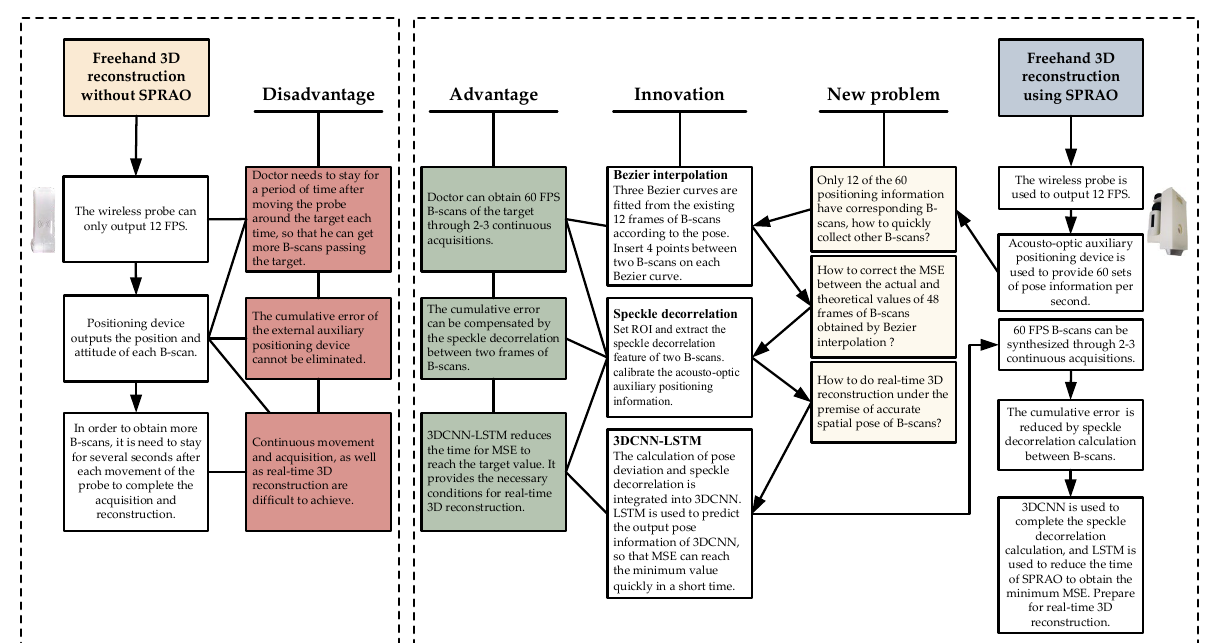
Figure 1. The research architecture diagram of SPRAO.